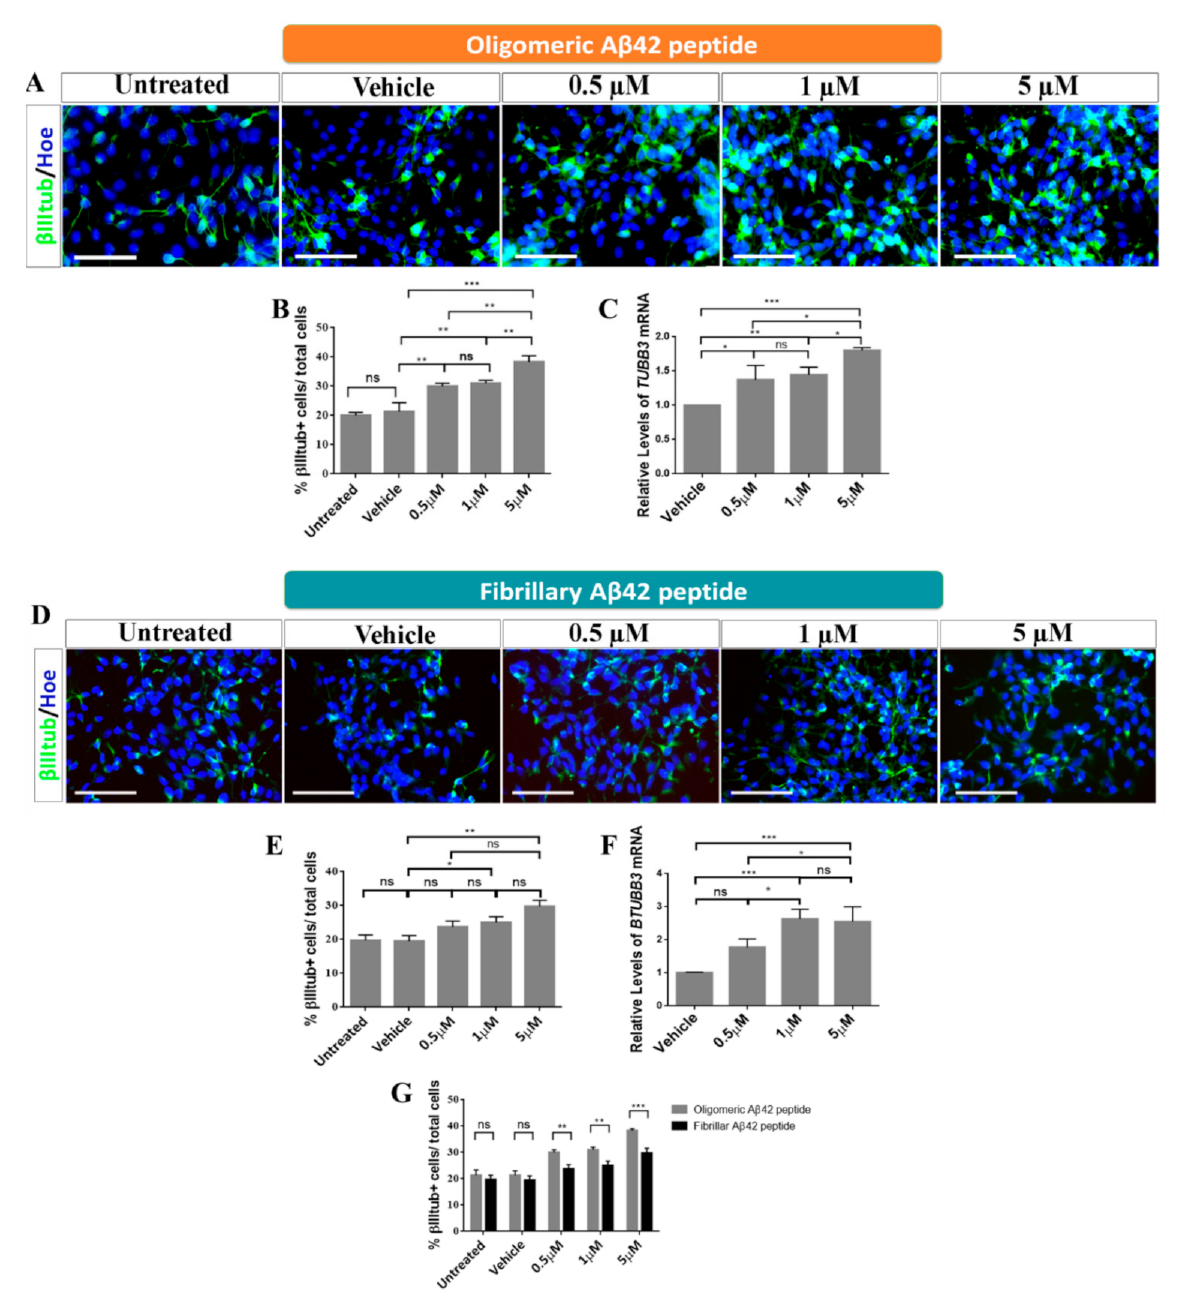
Figure 4. Roles of oligomeric and fibrillary A β 42 in neurogenesis. ( A ) Representative images showing immunoreactivity for β -III-tubulin ( β IIItub; green) after oligomeric A β 42 treatment. Scale bar, 50 µ M. ( B ) Analysis of the percentage of β -III-tubulin+/total cells after oligomeric A β 42 treatment. ( C ) Relative expression levels of TUBB3 mRNA by qRT-PCR after oligomeric A β 42 treatment. ( D ) Representative images showing immunoreactivity for β -III-tubulin ( β IIItub; green) after fibrillary A β 42 treatment. Scale bar, 50 µ M. ( E ) Analysis of the percentage of β -III-tubulin+/total cells after fibrillary A β 42 treatment. ( F ) Relative expression levels of TUBB3 mRNA by qRT-PCR after fibrillary A β 42 treatment. ( G ) Percentage of β -III-tubulin+/total cells comparing both added forms. Cell nuclei in A and D were counterstained by Höechst (blue). Data are represented as means ± SD of at least three different experiments ( n = 3). Statistical significance of one-way ANOVA with post hoc Tukey test; * p < 0.05; ** p < 0.01; *** p < 0.001; ns = not